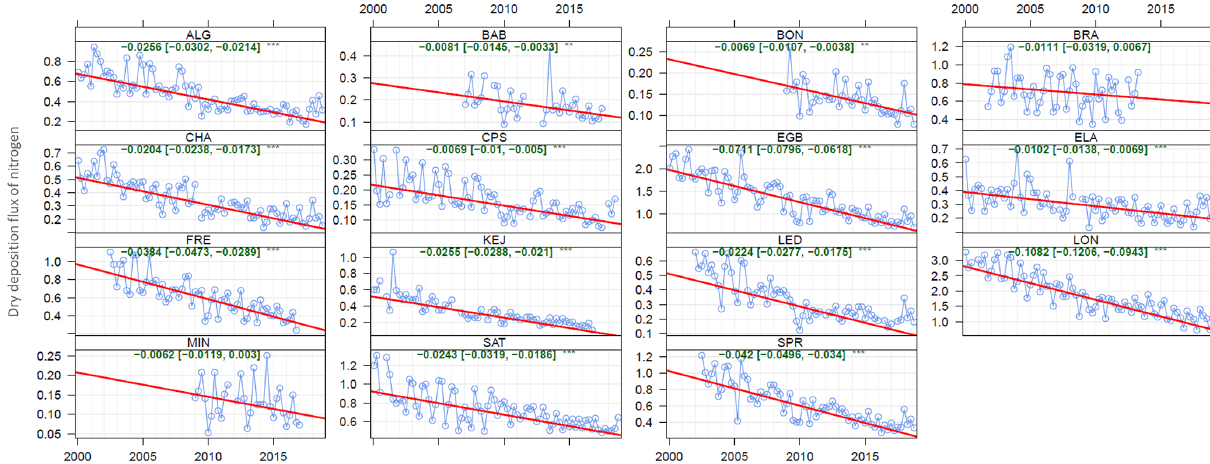
Figure 4. Annual trends in dry deposition fluxes of nitrogen at CAPMoN sites (kgNha − 1 yr − 1 ). Theil–Sen slope and 95% confidence interval (green text); trend line de-seasonalized using LOESS (red line); observed seasonal mean dry deposition fluxes (blue time series). Note: excludes NH 3 and other NO y dry deposition. Statistically significant trends shown with ∗∗∗ ( p < 0.001) or ∗∗ ( p <